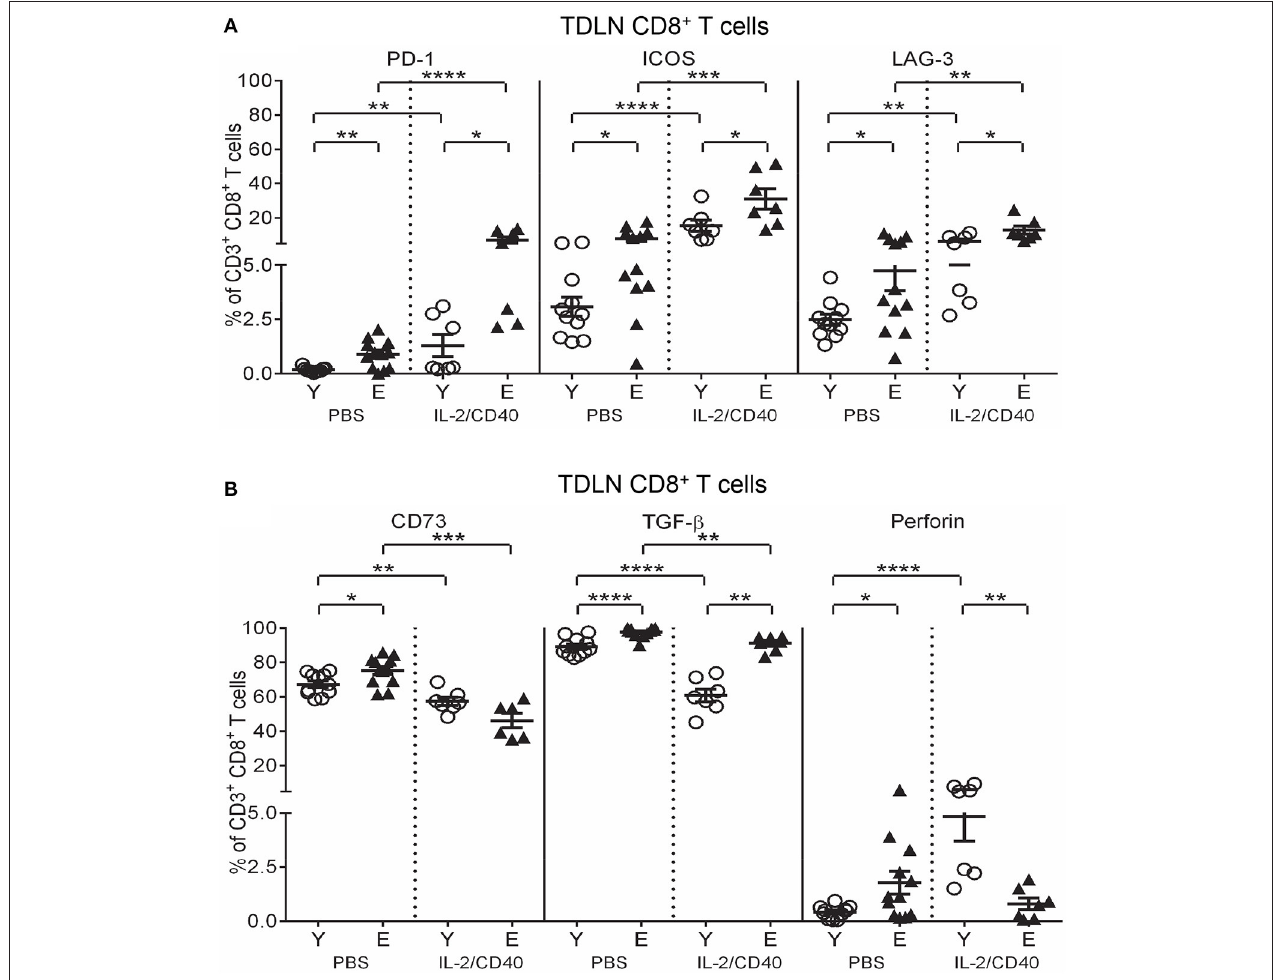
FIGURE 7 | IL-2/CD40 increases PD-1, ICOS, LAG-3, CD73, and TGF- β on TDLN CD8 + T cells. After two doses of IL-2/CD40 or PBS diluent, percentages of CD8 + T cells positive for PD-1, ICOS, and LAG-3 (A) and CD73, TGF- β and perforin (B) were measured in TDLNs from the young and elderly tumor-bearing mice described in Figures 5B and C using flow cytometry. Data are shown as mean ± SEM, n = 7 young and n = 6–7 elderly IL-2/CD40-treated mice, n = 11 young and n = 12 elderly PBS control mice, * p < 0.05, ** p < 0.005, *** p < 0.0005, **** p < 0.0001 comparing (i) young to elderly mice, or (ii) IL-2/CD40-treated mice to age-matched PBS control mice.